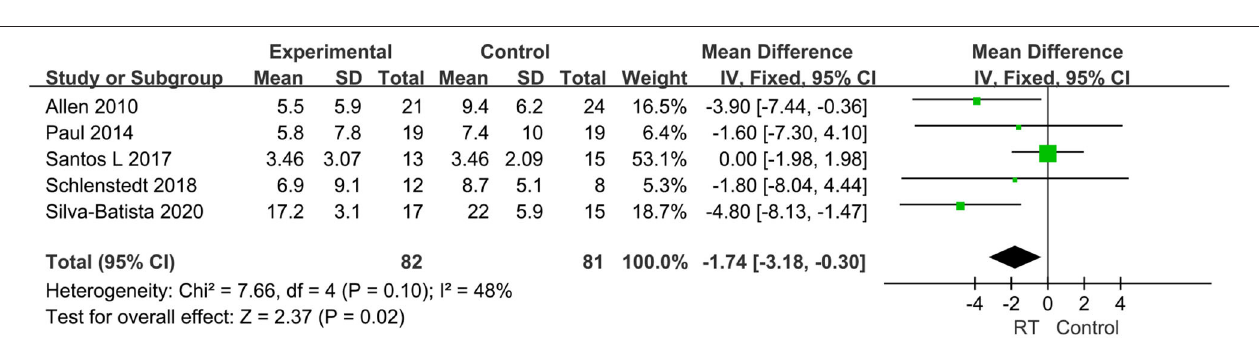
Frontiers in Neurology |